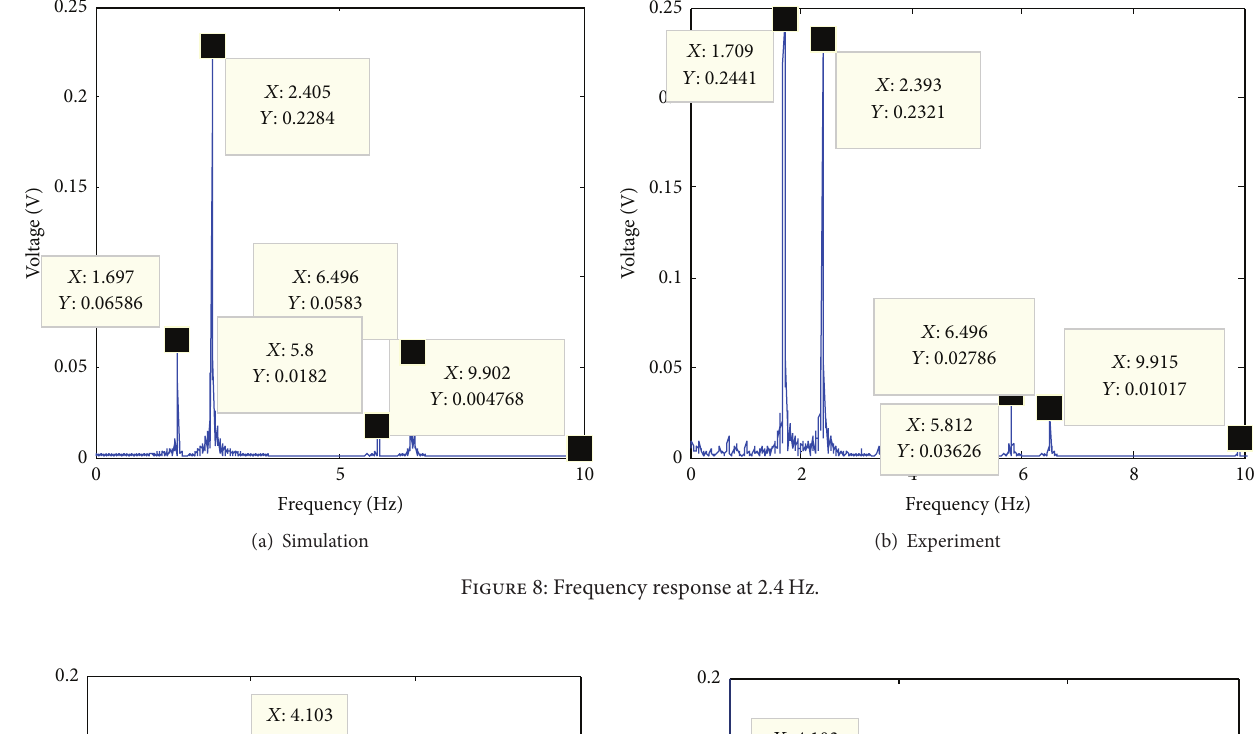
Figure 8: Frequency response at 2.4 Hz.